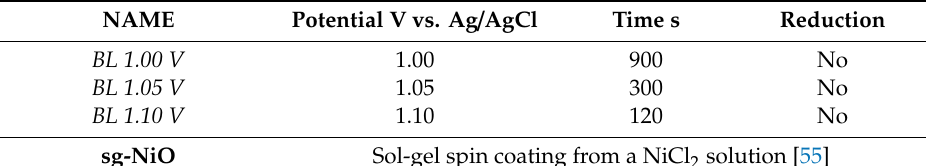
Table 1. The di ff erent NiO films produced and discussed in this work.